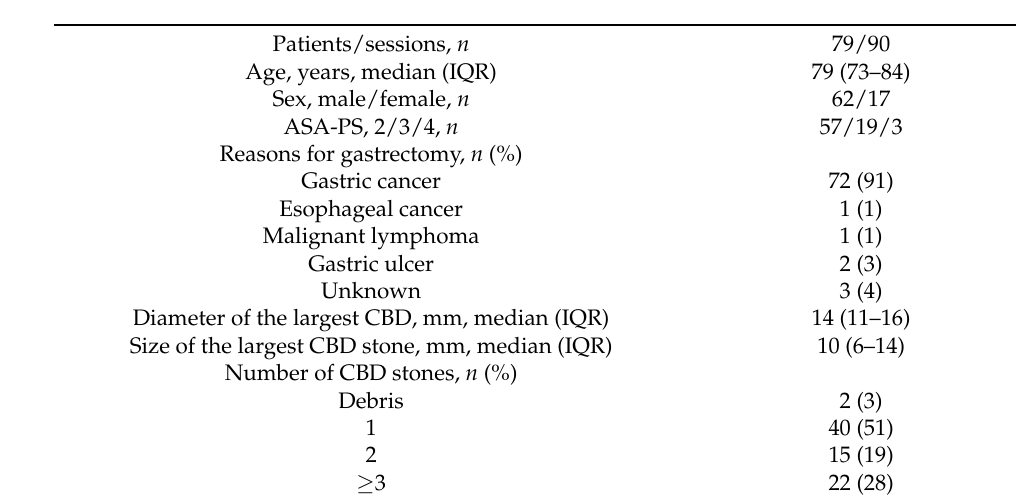
Table 1. Patients’ characteristics.